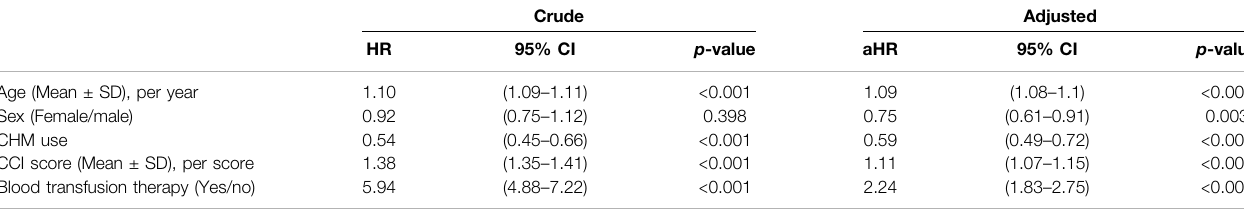
TABLE 4 | Risk of cardiovascular diseases-related mortality in patients with hereditary hemolytic anemias (HHAs) in Taiwan.